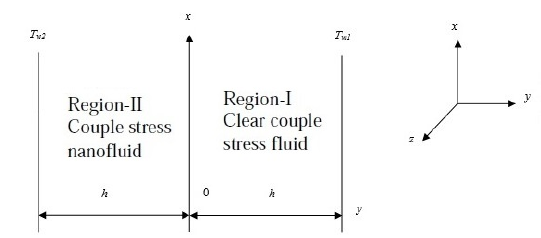
Figure 1: Physical representation of the